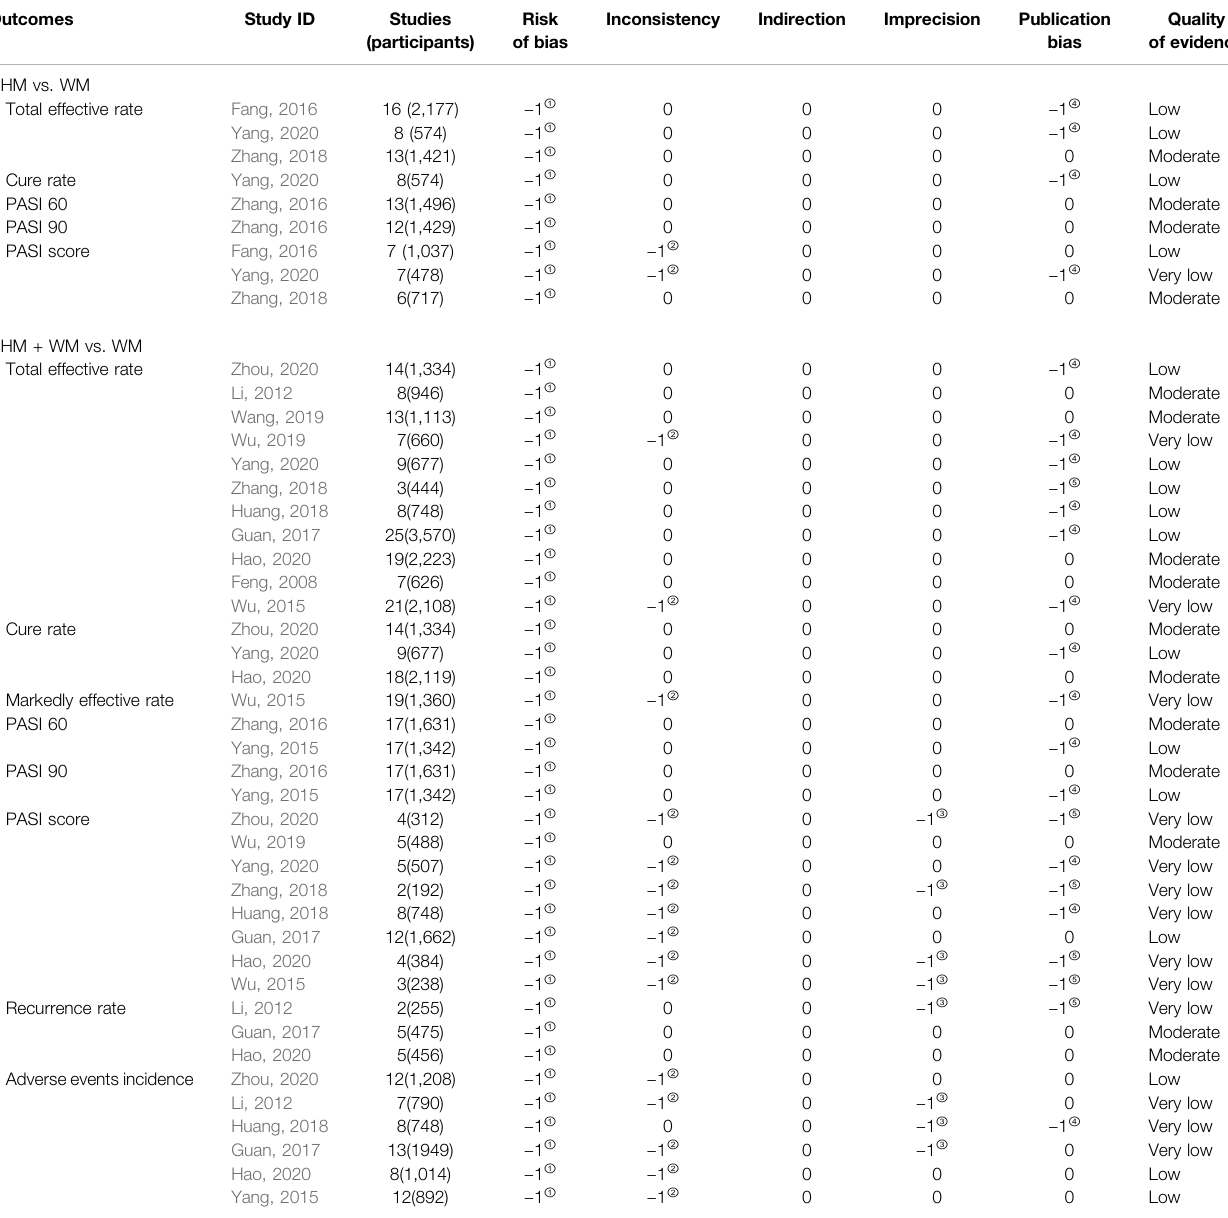
TABLE 7 | Results of evidence